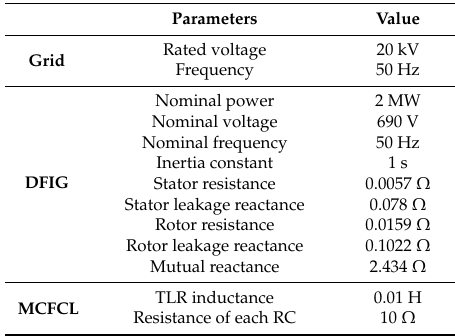
Figure 4. ( a ) Single diagram of the study system, ( b ) Power circuit of the SBFCL, ( c ) Control system of the DFIG converters. Table 2. System